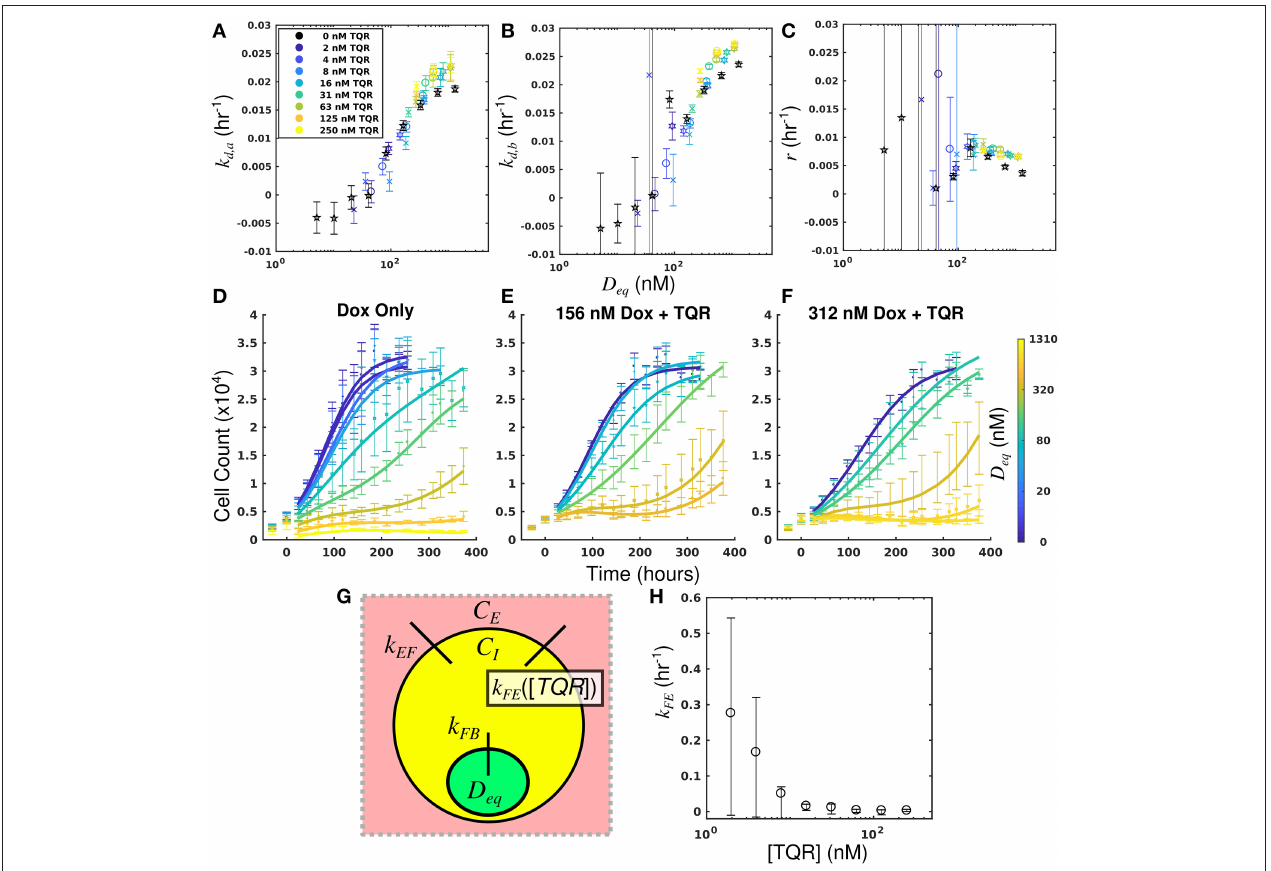
FIGURE 4 | Leveraging equivalent dose to estimate the effect of TQR in the MDA-MB-468 MDR1 cell line. The equivalent dose for each doxorubicin monotherapy condition was first calculated with the PK model parameters measured in the doxorubicin uptake studies. The equivalent dose statistic was then estimated for each co-treatment condition by matching treatment response parameters from co-treatment conditions to those from doxorubicin monotherapy conditions. Parameter values from all doxorubicin monotherapy and co-treatment conditions are plotted as a function of equivalent dose (A-C) . A subset of responses from doxorubicin monotherapy and co-treatment conditions are color-coded to their estimated equivalent dose (D–F) . Similar dynamics are observed with similarly-colored data, demonstrating the efficacy of the parameter matching in comparing treatment response timecourses. As TQR impairs the function of the MDR1 pump, we hypothesized the effect of TQR is limited to the k FE parameter (G) . With estimates of equivalent dose for all treatment conditions, the k FE value for each TQR concentration was estimated with the optimization routine summarized by Equation (7) (H) . These values, calculated with treatment response data, agree well with direct measurements of k FE reported in Figure 2 . We note the large confidence intervals are a result of the optimization approach, in which the value (1/ k FE ) was